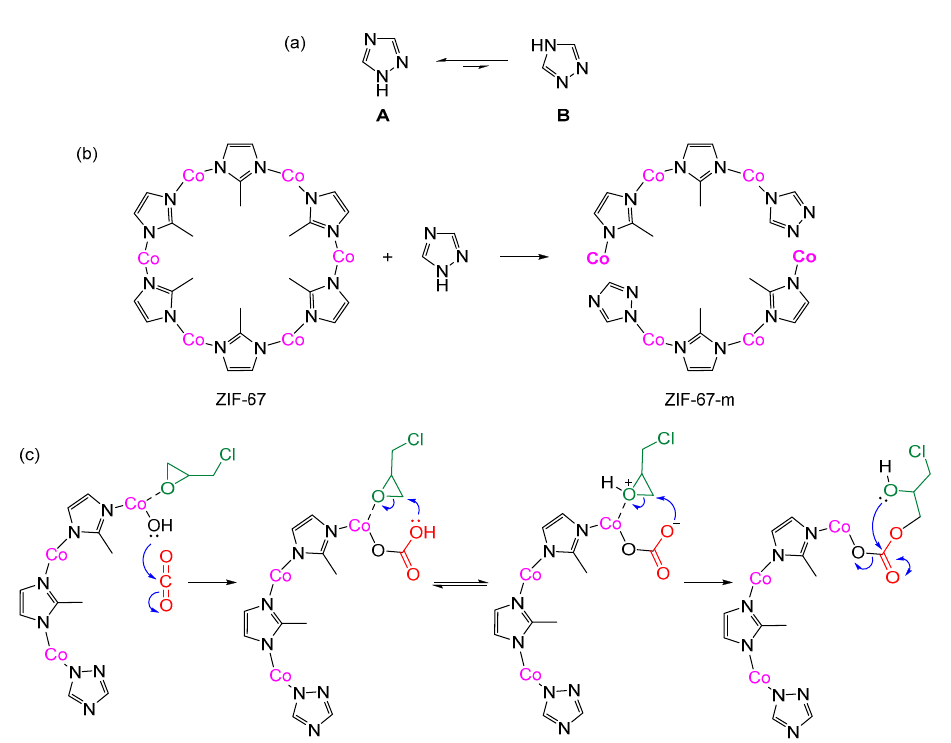
Figure 10. ( a ) Tautomeric forms of 1,2,4-triazole. ( b ) Proposed structural modification of ZIF-67 with 1,2,4-triazole. ( c ) Proposed reaction mechanism for the ZIF-67-m-catalyzed cycloaddition of epichlorohydrin and CO 2 .